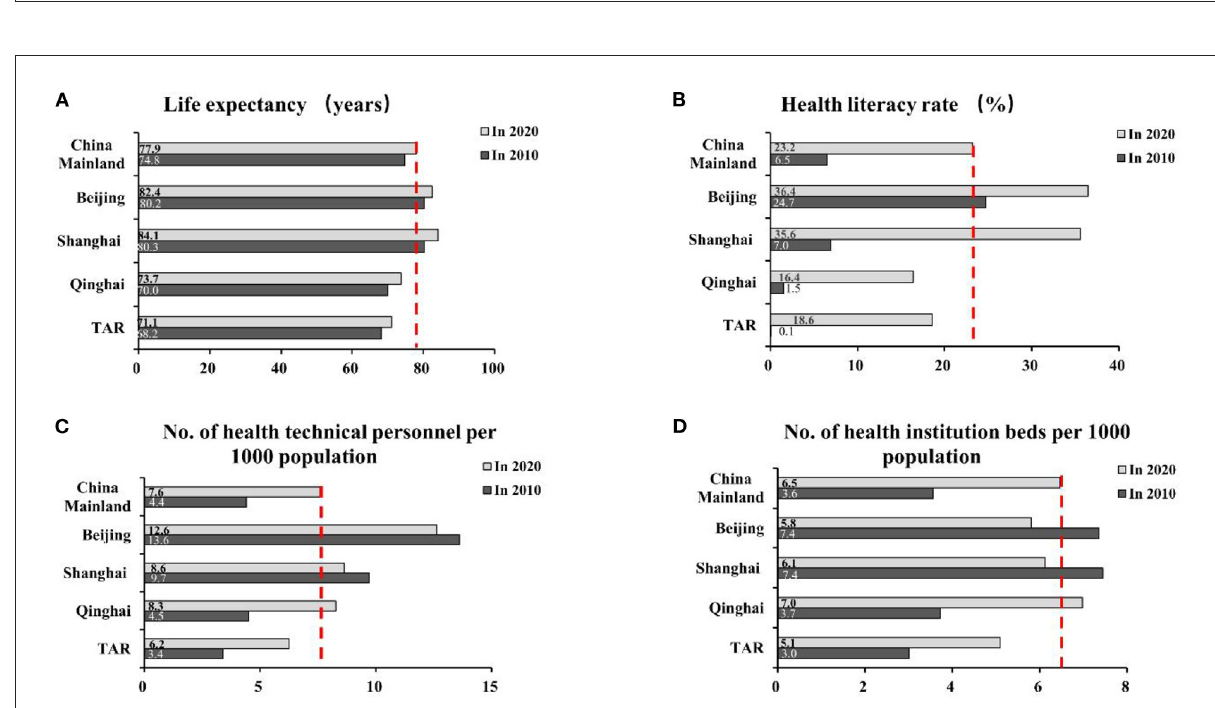
FIGURE3 Selected health indicators in Beijing, Shanghai, Qinghai, and TAR in comparison with mainland China overall, 2010 and 2020. TAR, Tibet Autonomous Region; dotted line indicates National average; (A, C, D) Data were from China Health Statistics Yearbook (2021); (B) data were from the official webpages of the four provincial and municipal governments